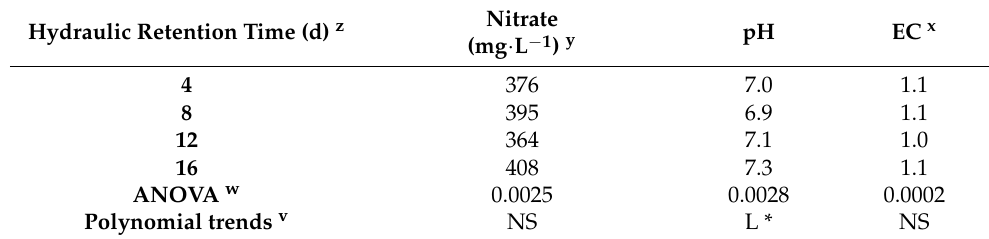
Table 7. Water measurements of HRT interval treatments with iron supplementation. Measurements were taken four times per week during the trial from nutrient